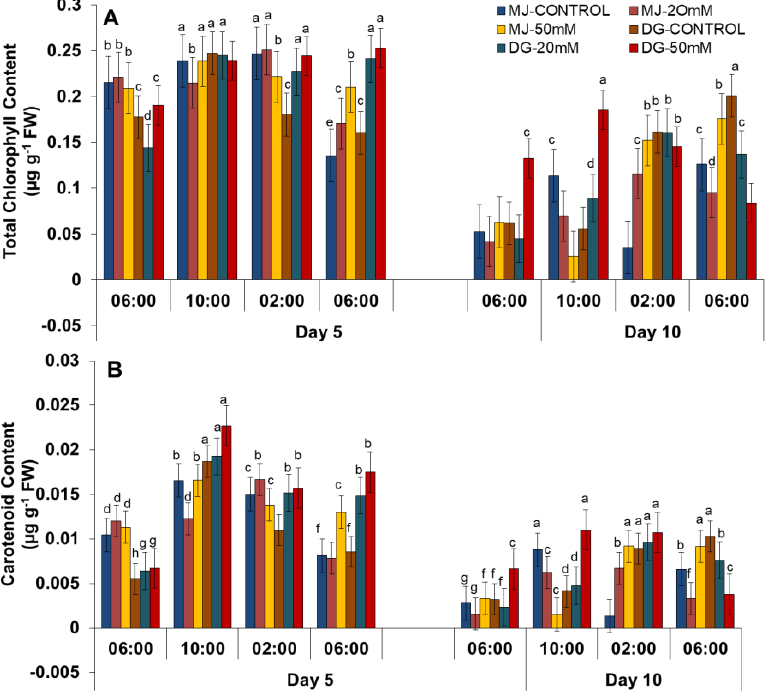
Figure 7. ( A ) Total chlorophyll and ( B ) carotenoid content in spinach genotypes Delhi green (DG) and Malav Jyoti (MJ). Results are presented for the controls (MJ control; DG control), 20 mM of NaCl treatments (MJ-20 mM; DG-20 mM), and 50 mM of NaCl treatments (MJ-50 mM; DG-50 mM). Sampling was performed (on the basis of the circadian cycle) at 4 h intervals which corresponded to the exact times of 6 am, 10 am, 2 pm and 6 pm on both day 5 and day 10 of salinity stress. Vertical bars indicate mean ± S.E. for n = 3. Means with different letters are significantly different at p ≤ 0.05 according to the Tukey’s studentized range test. Data for day 5 and day 10 are shown separately and the colors of the bars correspond to treatments, which remain the same for different hours.